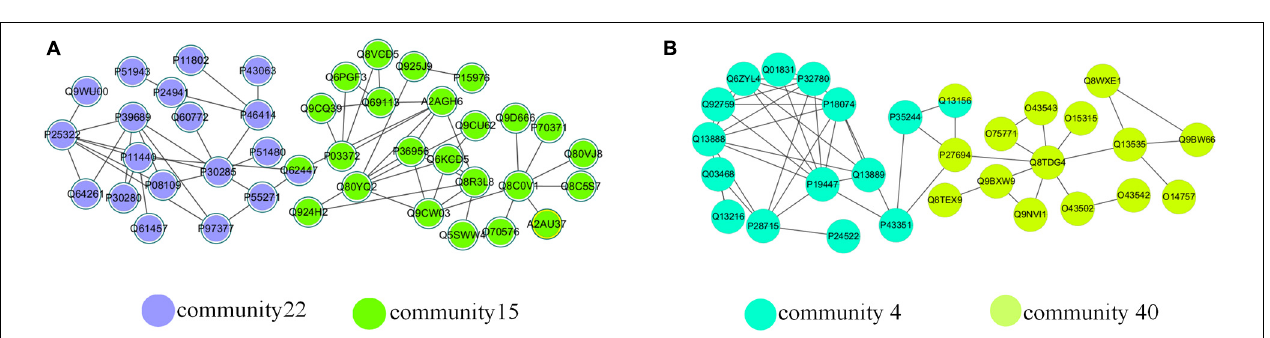
FIGURE 10 | Overlapping structures in (A) M. musculus network and (B) H. sapiens